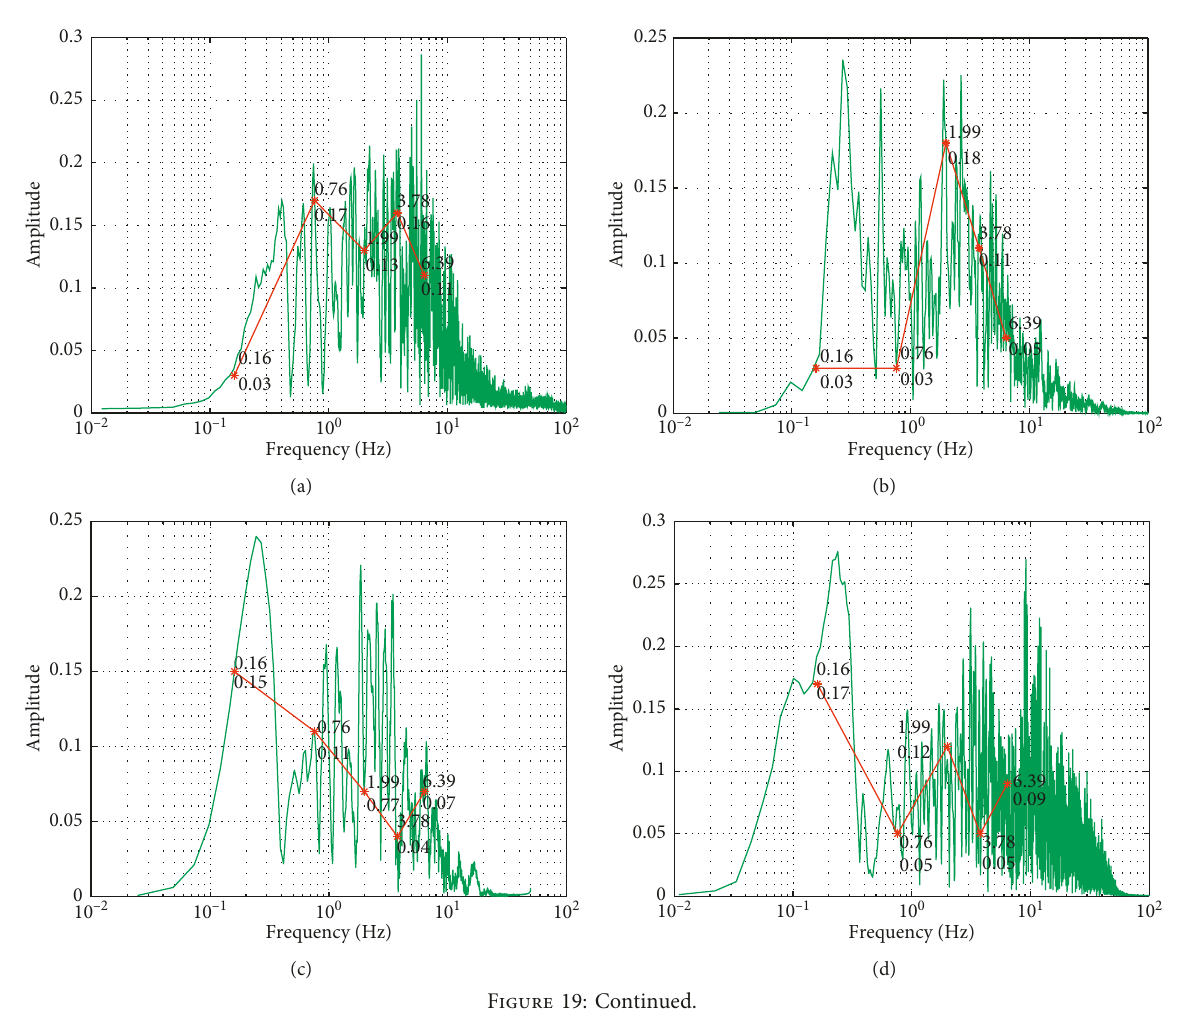
Figure 18: Three stories with maximum modal displacements in the first five natural